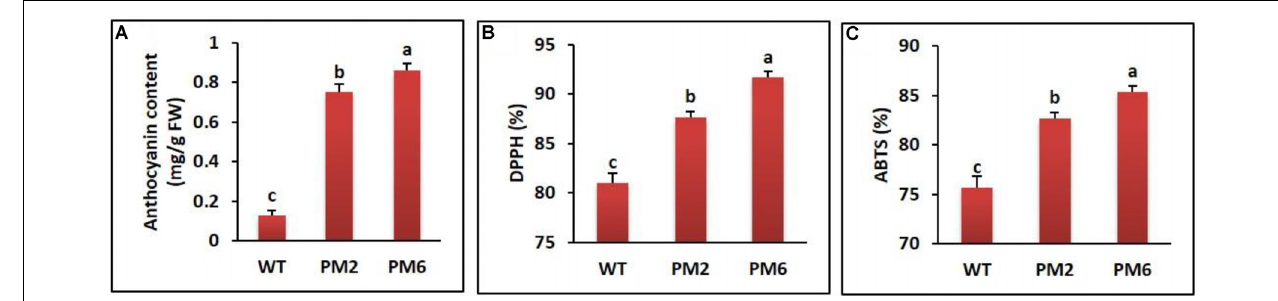
FIGURE 1 | Comparison of anthocyanin content (A) and ROS-scavenging activities assessed by DPPH (B) and ABTS (C) assays in the T 2 -PM6, T 2 -PM2, and the wild-type (WT) plants grown in the greenhouse for 6 weeks. Error bars indicate the SEM. FW, fresh weight.